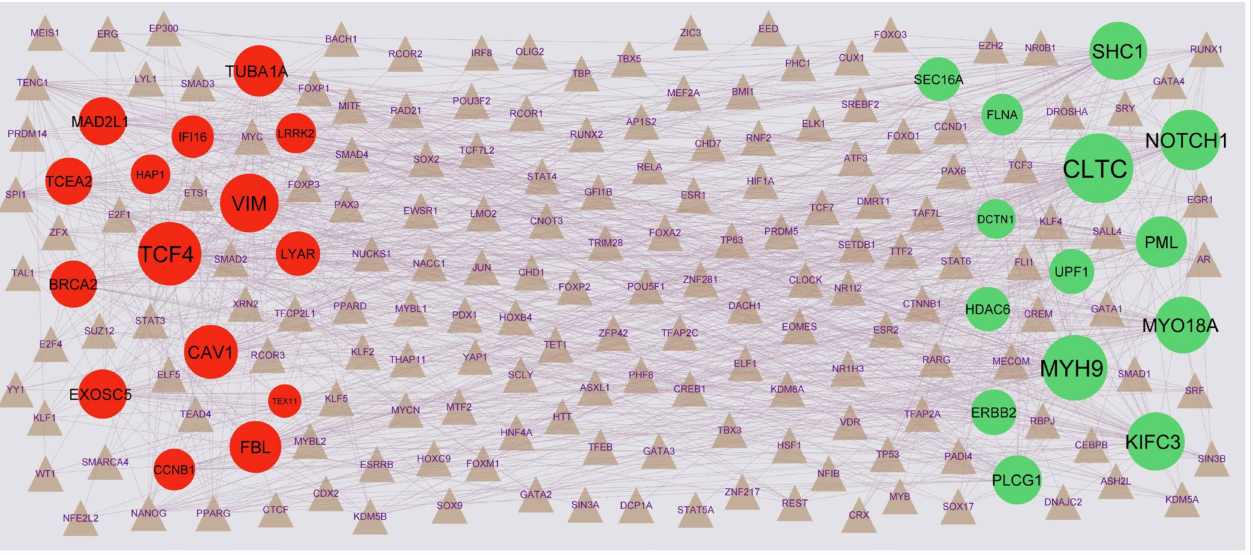
Figure 7. Target gene–TF regulatory network between target genes. The gray-color triangle nodes represent the key TFs; up-regulated genes are marked in green; down-regulated genes are marked in